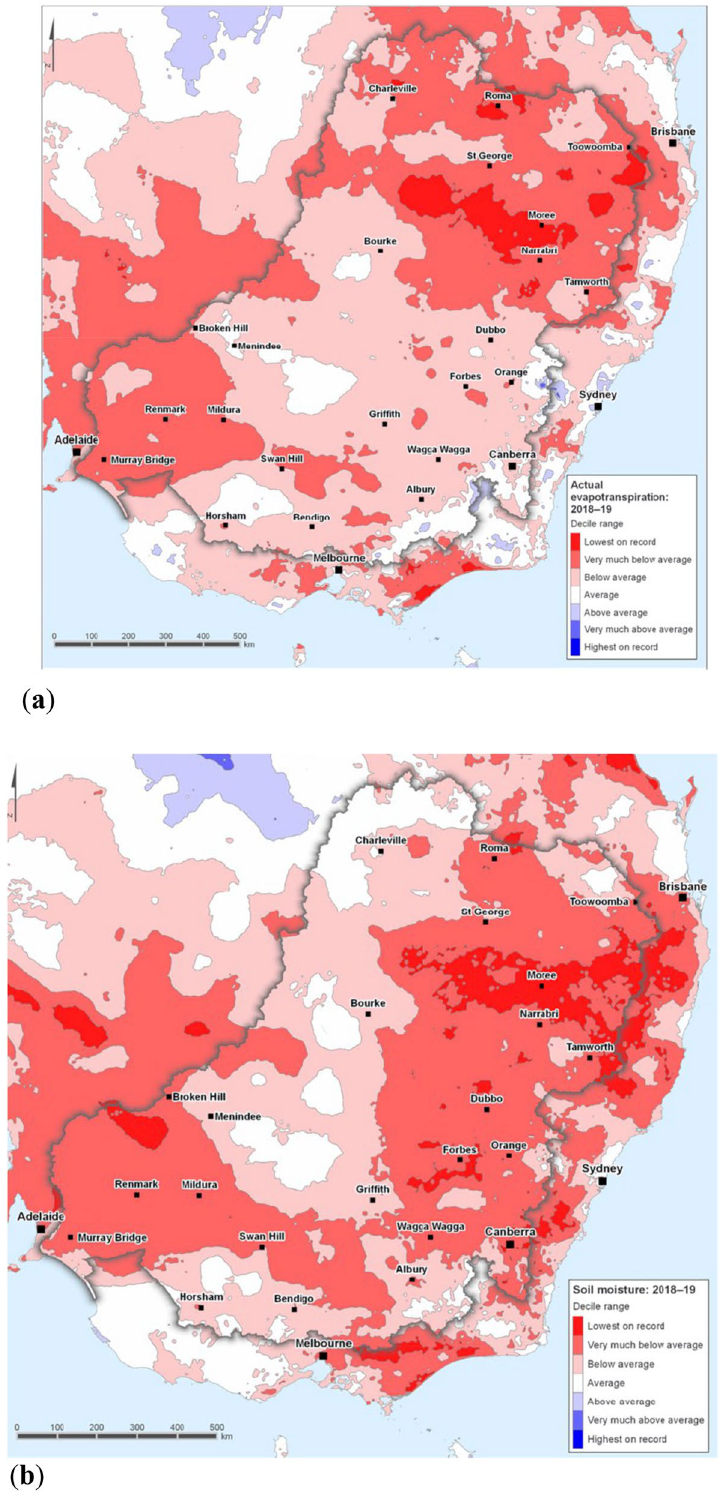
Figure 7. Annual deciles of actual evapotranspiration and soil moisture 2018–2019. Map of southeast Australia showing for the MDB region deciles during the 2018–2019 year for, (a) annual area-averaged actual evapotranspiration. Note the below average decile in the southeast corner of the MDB, and (b) annual area-averaged soil moisture. Note the very much below average decile in the southeast corner of the MDB. (Reproduced with permission under Creative Commons Attribution Licence 3.0 from the Australian Bureau of Meteorology. Available at: http:// www. bom. gov. au/ water/ nwa/ 2019/ mdb/ clima teand water/ clima teand water.